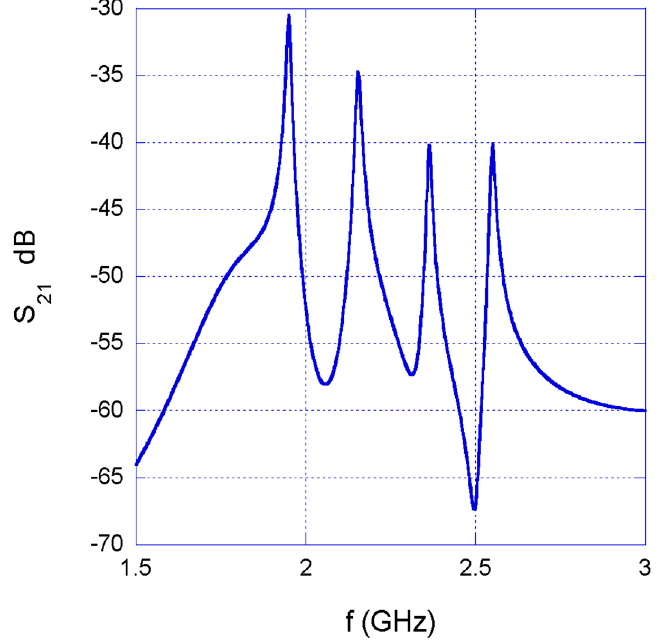
Figure 5. S 21 MWO simulation of the designed network.